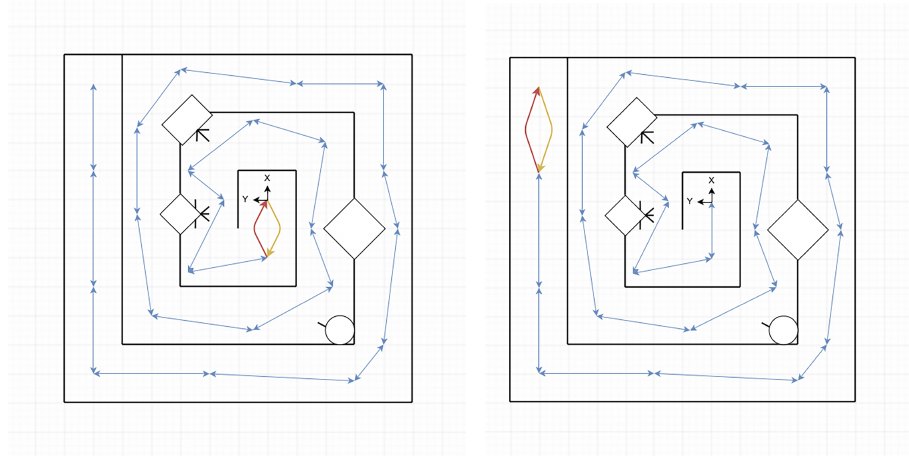
Figure 6. Labyrinth arena